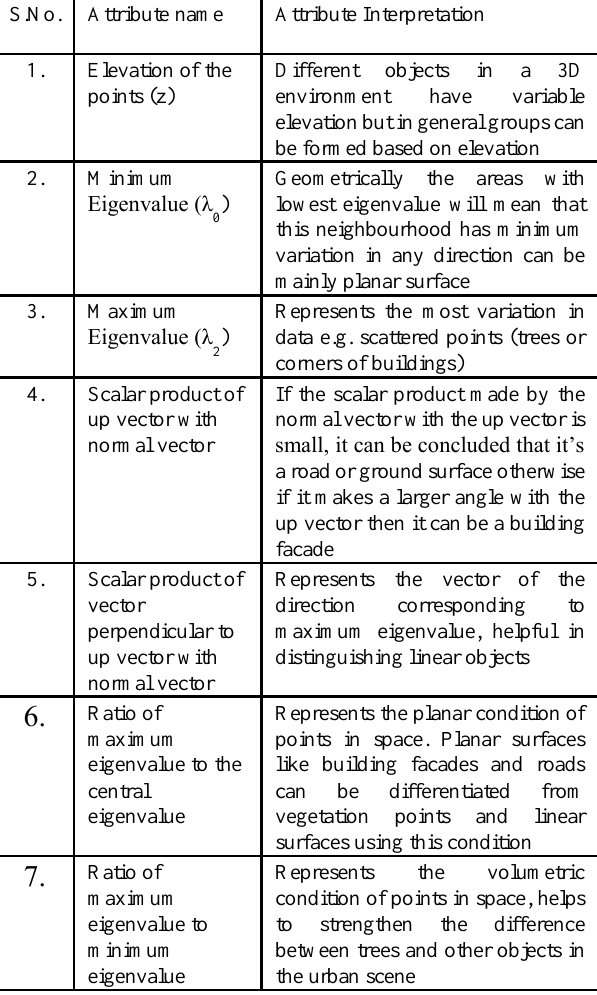
Figure 4: Representation of volumetric, linear, planar areas in a Table 1: Summary of feature vector to be used in data mining LiDAR data (Lalonde et. al, 2006) Feature vector for each point are developed using python In the given study area, trees represent scattered objects, poles and trunk of trees represent linear objects and building facades and pavement surfaces as planar objects. The PCA based classification just predicts the geometric condition of the objects in space but cannot identify which object is it.